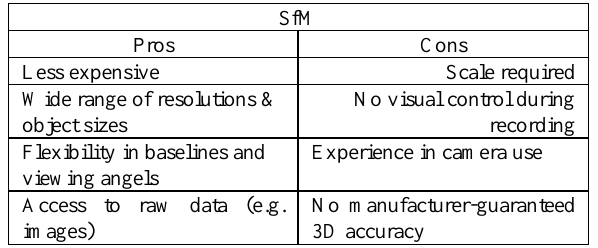
Table 6. Advantages and disadvantages of SfM.